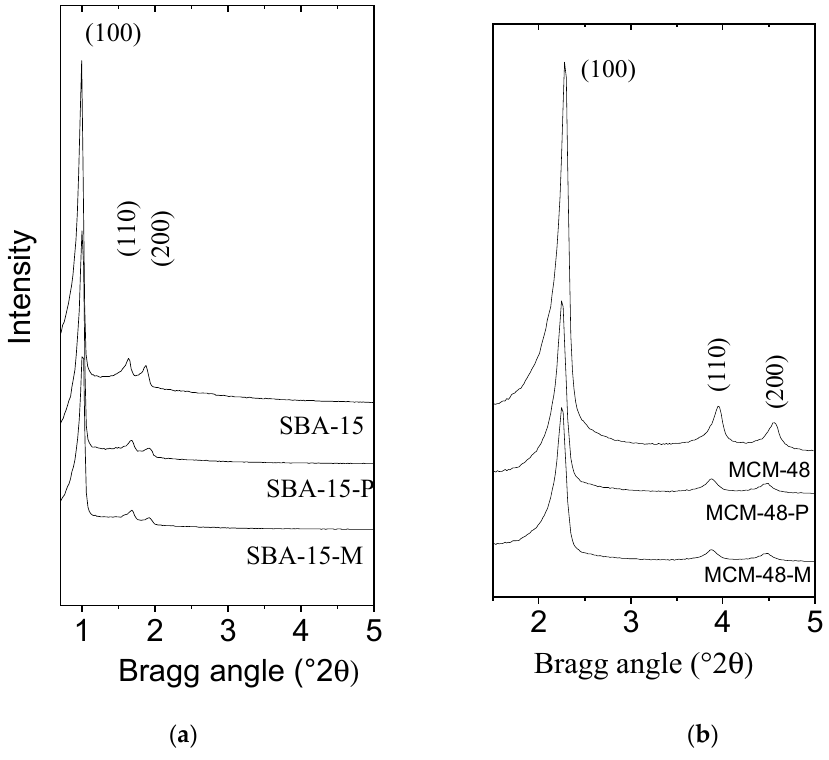
Figure 1. XRD of the initial and the modified SBA-15 ( a ) and MCM-48 ( b ) materials. Nitrogen adsorption and desorption isotherms of the parent and amino-modified SBA-15 and MCM-48 samples are presented in Figure 2.